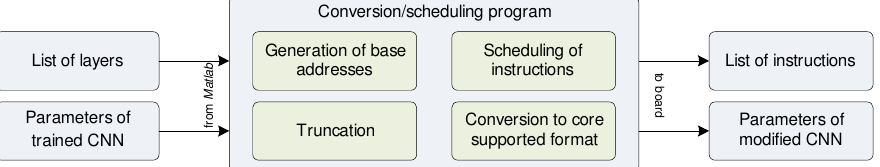
Figure 3. Signal flow graph of the binarized convolution and batch normalization.